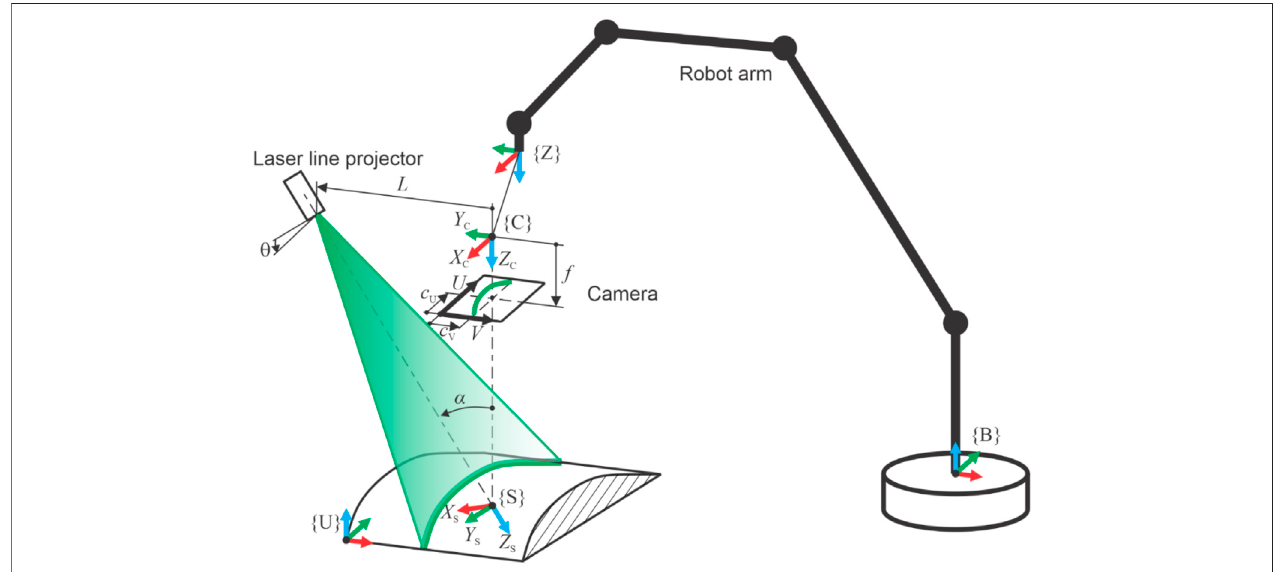
FIGURE 2 | Schematic representation of the 3D measurement principle based on laser triangulation, where the required scanning movement is performed by the robotarm while holdingthe laserpro fi lometer. Relevantcoordinate systems(c.s.) areasfollows: robot base c.s. {B}, robot zero c.s. {Z}, sensor c.s. {S}, camerac.s. {C}, and user c.s.